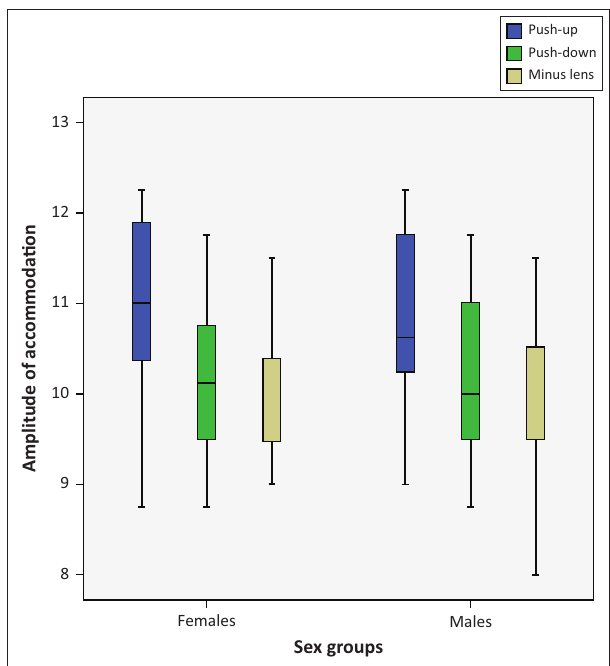
FIGURE 2: Box plots for the amplitude of accommodation for the various methods of accommodation measurement for all subjects as a function of sex groups. The x -axis represents the methods used to measure the amplitude of accommodation while the y -axis represents the distribution of the measurements of the amplitude of accommodation.